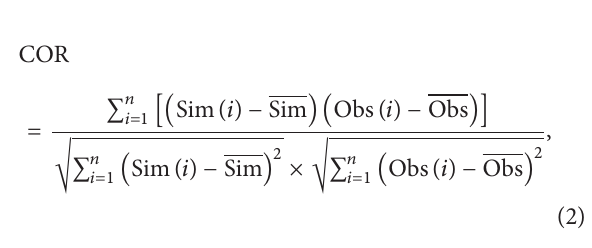
Table 3: The evaluation statistics of CMAQ performance on PM